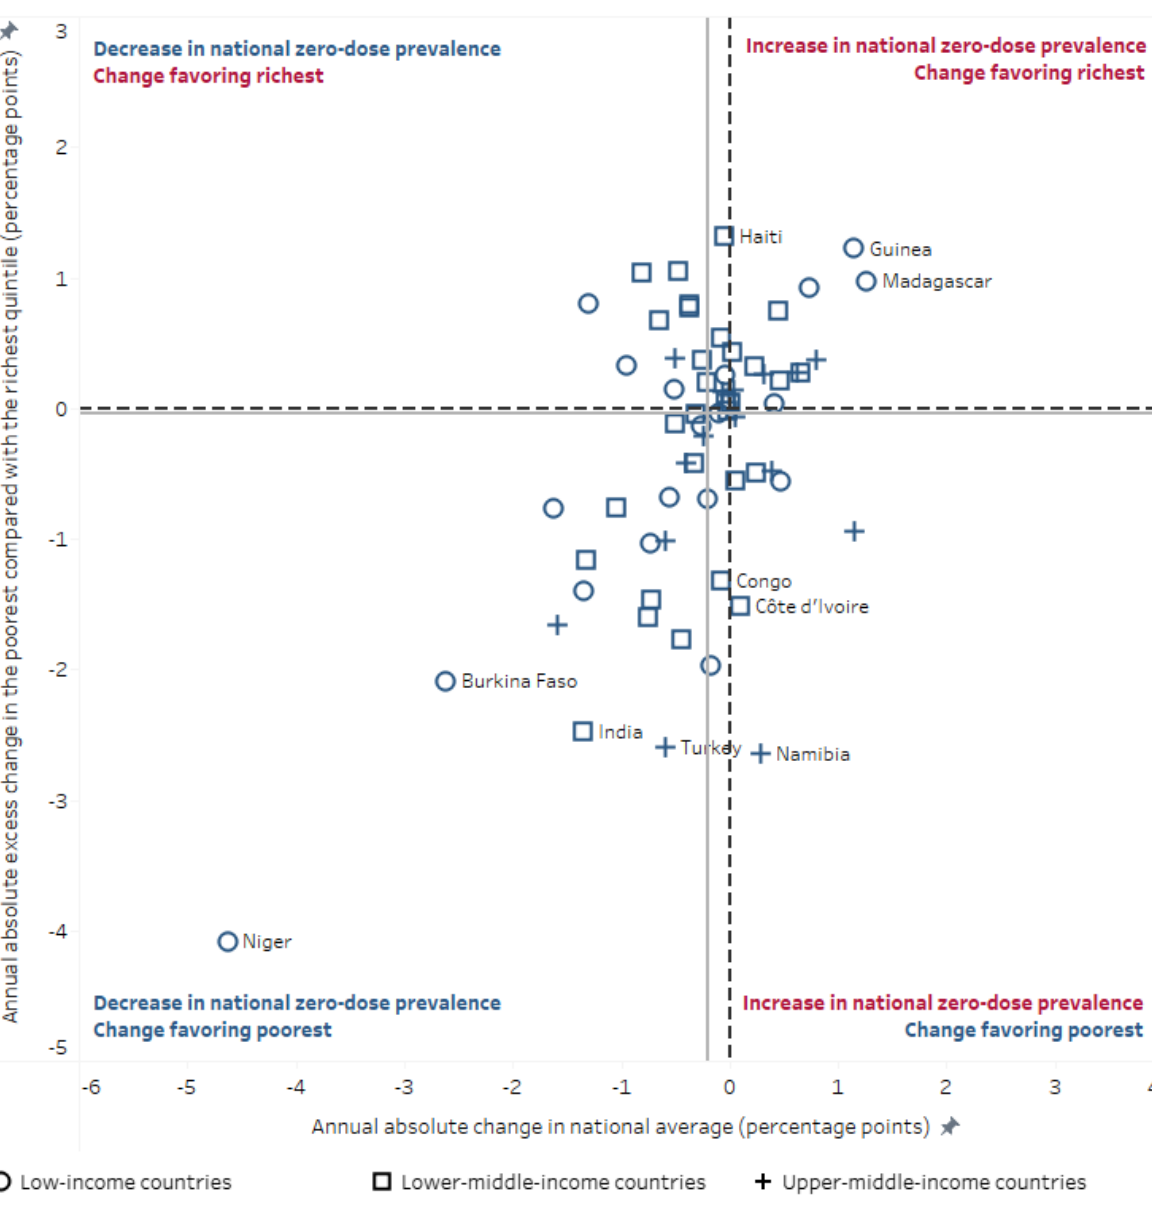
Figure 2. Change over time in national average percentage of children aged 12–23 months who did not receive any doses of DTP-containing vaccine, zero-dose DTP, and in wealth quintile 1 compared with wealth quintile 5, in 65 countries. Data taken from DHS and MICS 2000–2009 and 2010–2019. Every country is represented by a shape, which corresponds to its 2021 World Bank country income level grouping. For every study country, the annual absolute change in national average was calcu- lated by subtracting the national average prevalence in survey year 1 (2000–2009) from prevalence in survey year 2 (2010–2019) and dividing by the number of intervening years. The annual absolute excess change was calculated by subtracting the annual absolute change in quintile 5 from the an- nual absolute change in quintile 1. The gray lines indicate the median values across countries. DHS = Demographic and Health Survey. DTP = diphtheria–tetanus–pertussis vaccine. MICS = Multiple Indicator Cluster